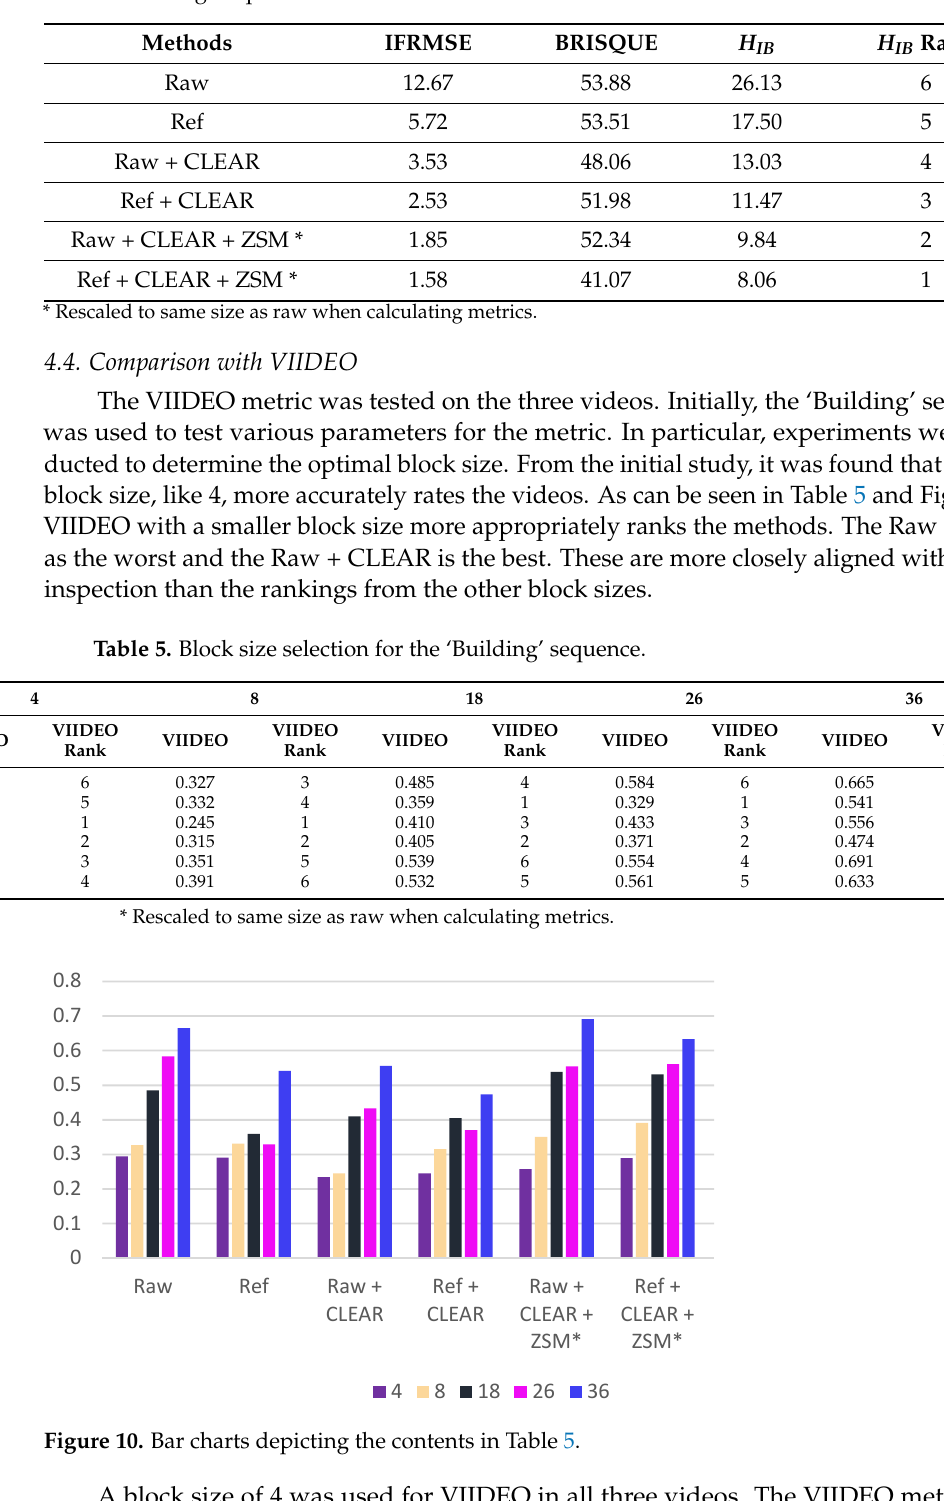
Table 4. Comparison of different approaches using BRISQUE, inter-frame RMSE, and hybrid metrics for the ‘Building’ sequence.